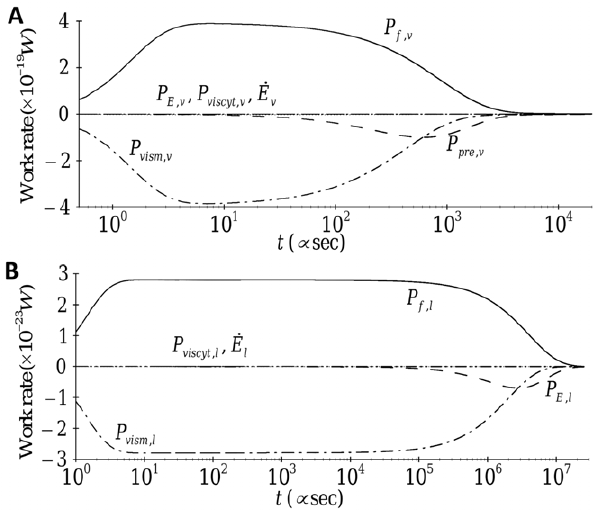
Figure 8. Time evolution of the individual work-rate contribu- tion of each term for the ( A ) transverse and ( B ) longitudinal components of the applied force.